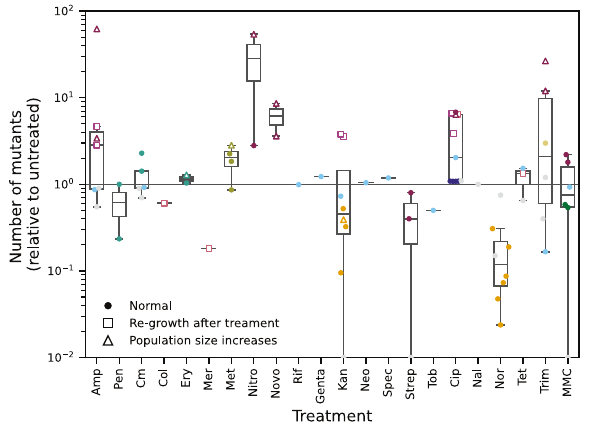
Fig. 3 Effect of antibiotic treatments on genetic diversity. The median of the raw number of mutants detected on selective medium among several replicate populations is used as an approximation of genetic diversity. This quantity is relative to the untreated control (horizontal line y = 1). The colours correspond to different studies and are the same than on Fig. 2. Open squares indicate the use of a modi fi ed fl uctuation assay protocol where treated cells are regrown in fresh antibiotic-free medium before being plated. Open triangles indicate the particular situation where antibiotic treatment increases population size. All other data points (standard fl uctuation assay, no increase in population size) are shown as fi lled